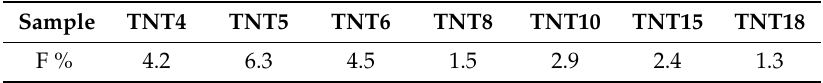
Table 3. Fluorine ions’ presence on the surface of TNT coatings based of XPS